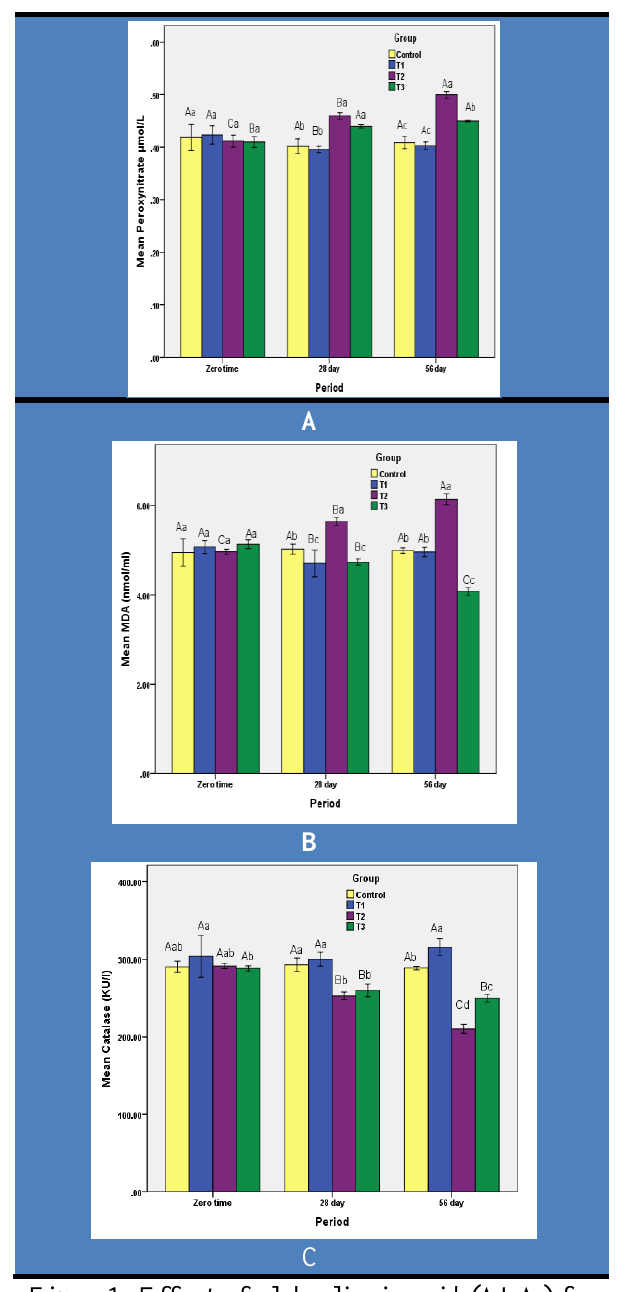
Figure1. Effect of alpha lipoic acid (ALA) for 28 and 56 days on serum peroxynitrite (A), (MDA) (B), catalase(C) Concentrations of hydrogen peroxide treated male rats.